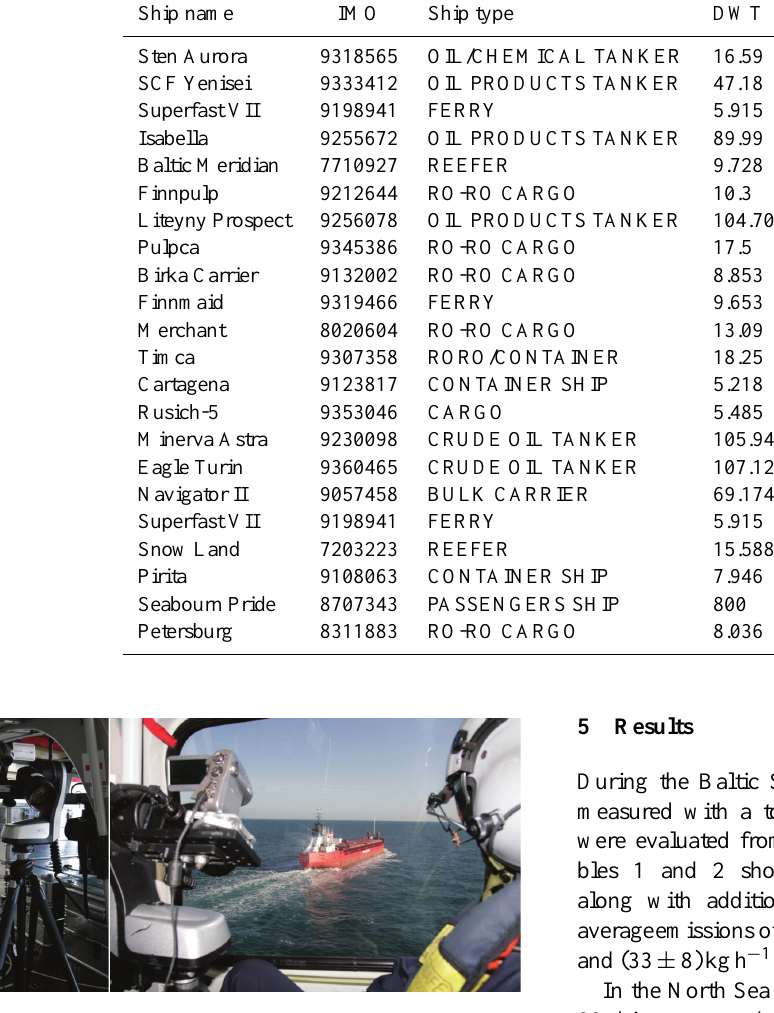
Fig. 8. Measurement setup in a Dauphin helicopter used in the North Sea campaign. The picture shows the telescope with a video camera for documentation on the side. The aluminium box in the bottom right of the picture contains the spectrometer. The other boxes con- tain in situ gas analysers. The same system was used in the CASA- 212 airplane in the Baltic